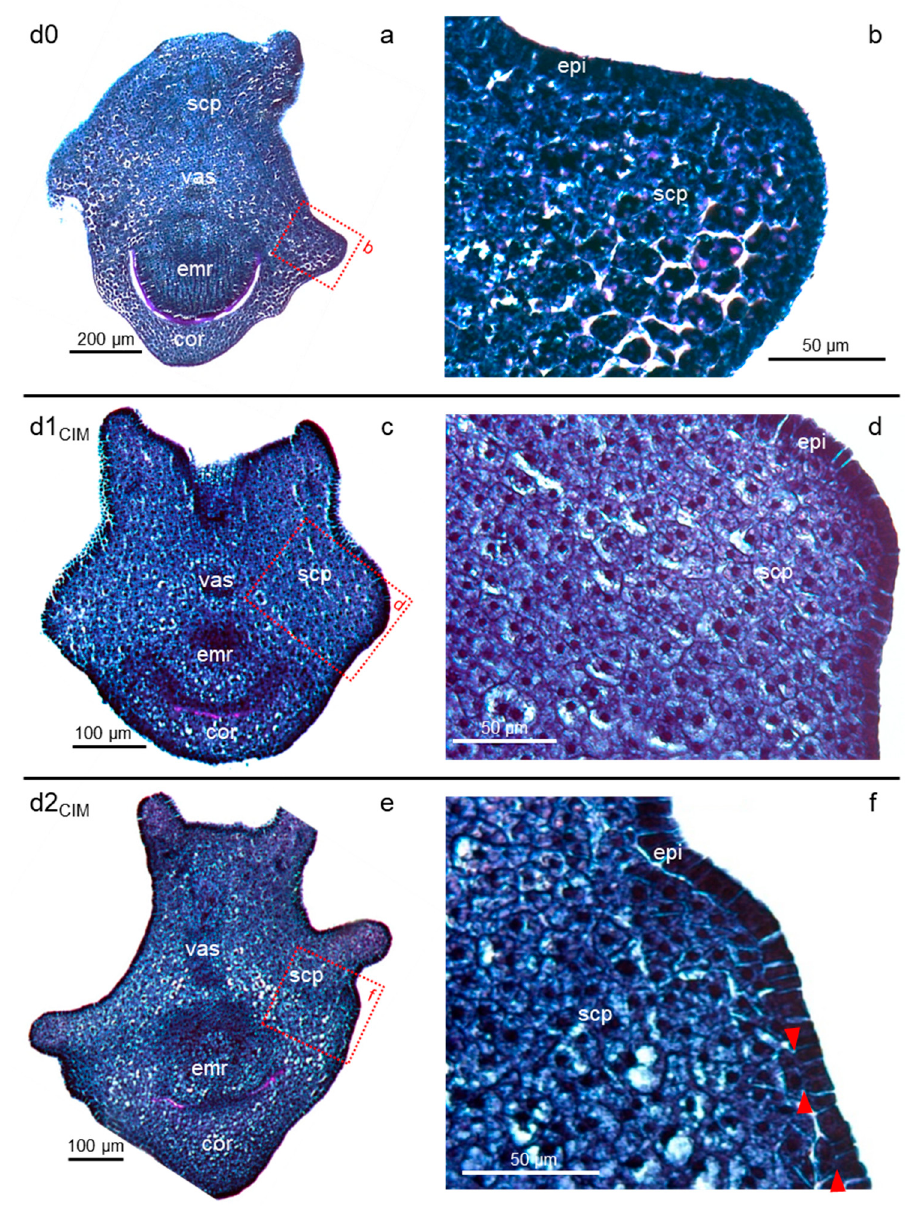
Figure 2. Initiation of callogenesis. Panels show frontal to oblique PAS-NBB-stained sections of izEmb explants at the beginning of induction with 2,4-D ( a , b ), one day after induction ( c , d ), and two days after induction ( e , f ). Cell morphology changes were observed after one day. The first epidermal cells divided in the periclinal orientation after two days (red triangles). Dotted red boxes indicate close-up views of the cross-sections. cor—coleorhiza; emr—embryonic root; epi—scutellum epidermis; scp—scutellum parenchyma; vas—scutellum vasculature.